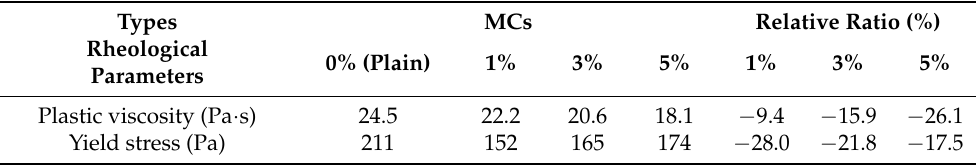
Table 4. Rheological parameters by the Bingham model.